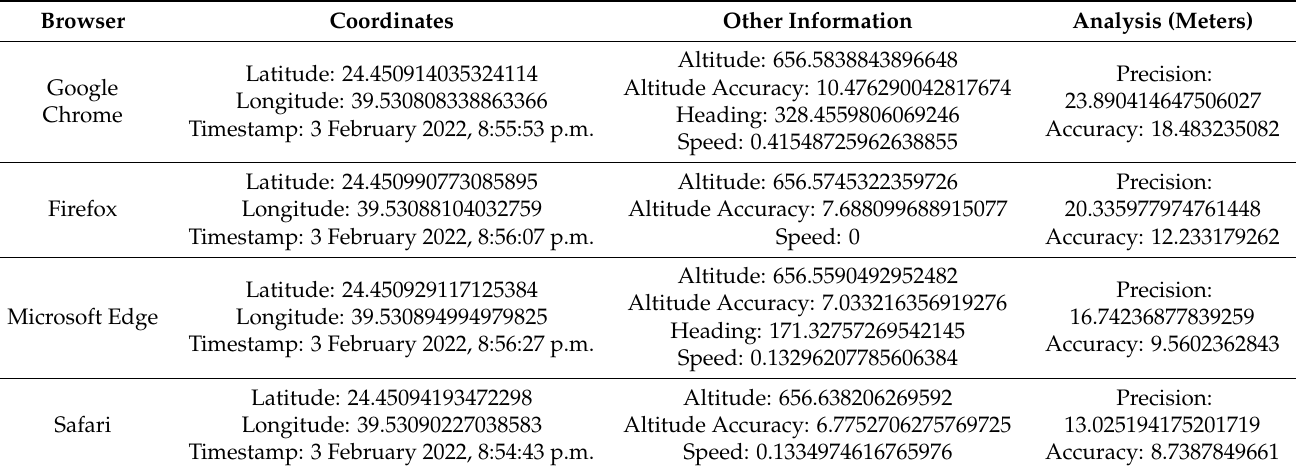
Table 8. Result and Comparison of W3C Geolocation API in iPhone by a wireless network (DSL).